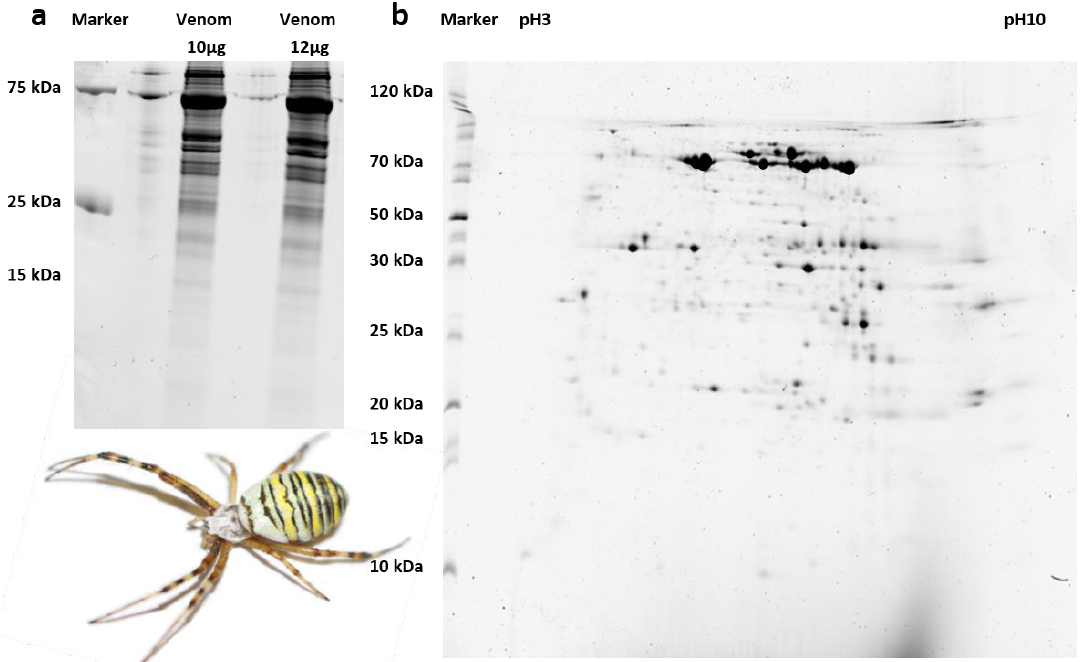
Figure 2. Analysis of A. bruennichi venom proteins by PAGE. ( a ) 1D-PAGE of venom proteins at two concentrations, showing identical banding patterns, with most proteins larger than 25 kDa. ( b ) 2D-PAGE, showing that the proteins cover a range of pI values but cluster around pH 7 and confirming that most proteins are larger than 25 kDa.